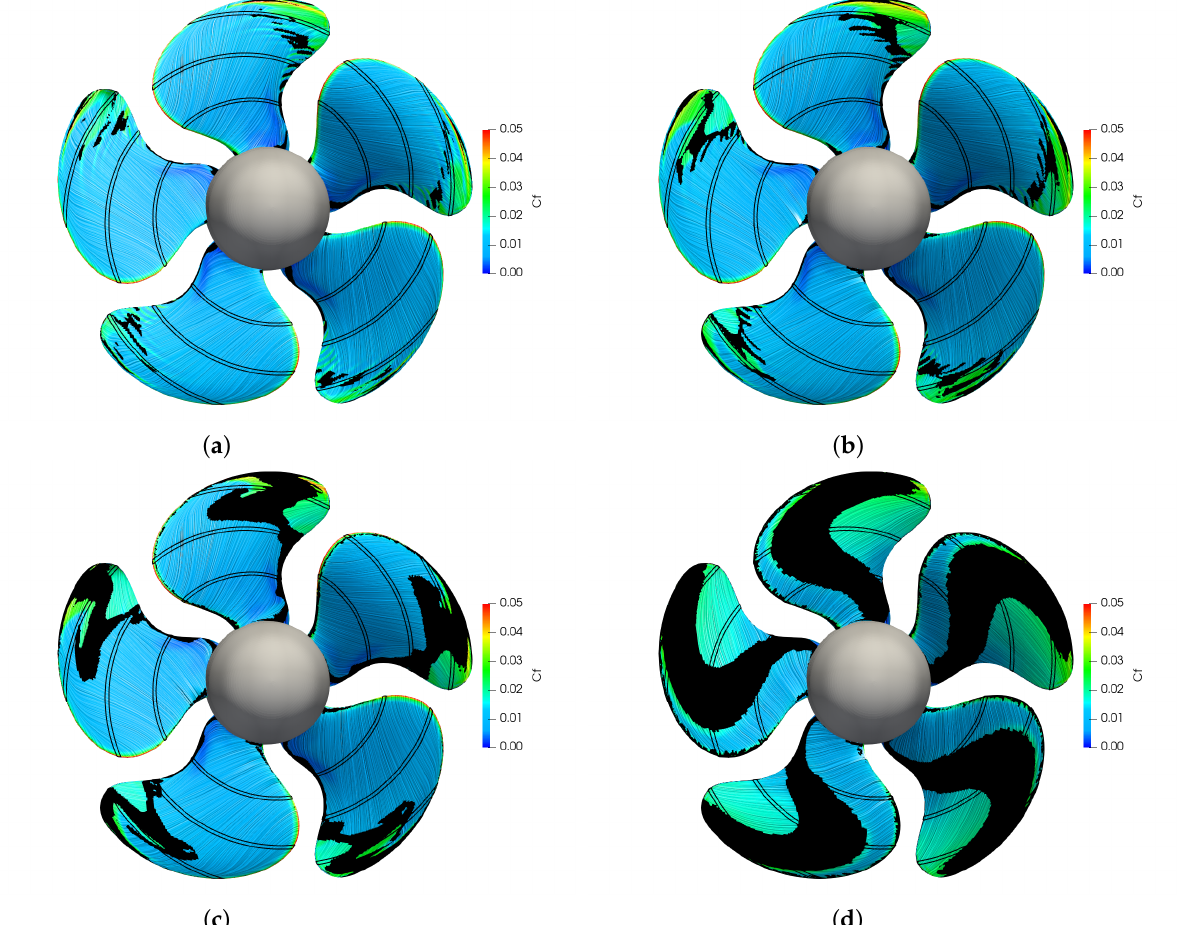
Figure 19. Predicted SepInd , wall limiting streamlines and C f with different Tu levels. ( a ) Tu = 0.1%; ( b ) Tu = 0.5%; ( c ) Tu = 1%; ( d ) Tu =